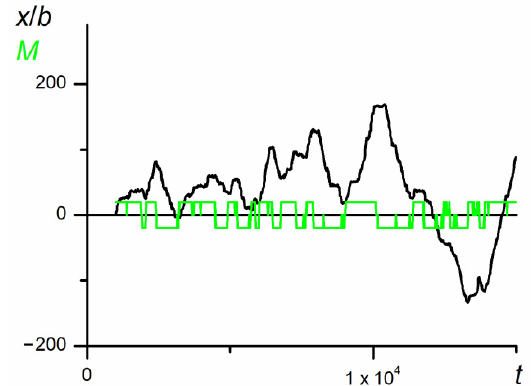
Figure 2. The dependence of the position of the center of mass of copolymer along the nanopore on the number of MC steps ( N = 100, ε PP / k B T = − 1 and 0 for P1 and P2, respectively, D = 3 b , the coordinate x = 0 was assumed as a starting point of the fragment of trajectory shown in the Figure). The mutual orientation, M , along the x -axis is marked in green. The chart is based on the data recorded in periods of t E = 10 3 elementary steps.